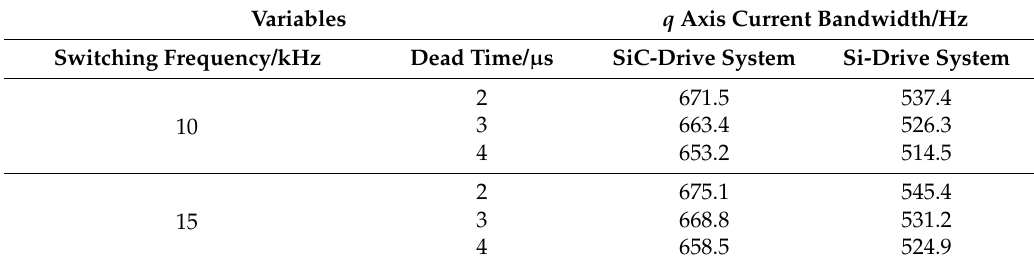
Table 3. The frequency response results of q -axis current with different switching frequency and dead